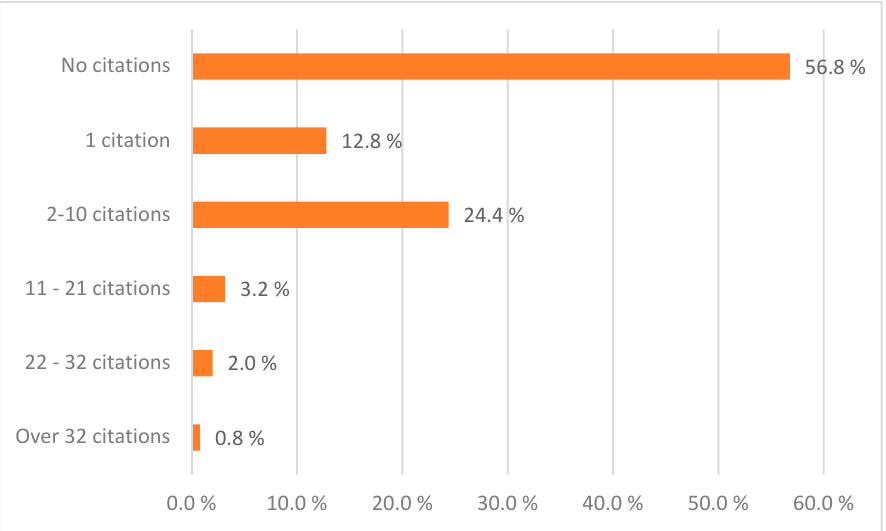
Figure 2. Citations since 2014 to the articles in predatory journals.